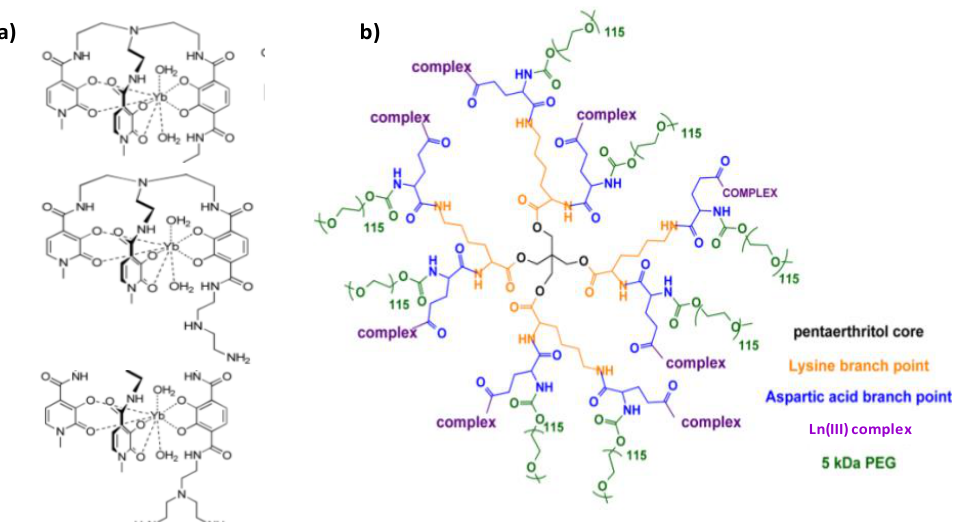
Figure 17. Structures of ( a ) Ln(III) complexes for MRI and NIR imaging agents and that of ( b ) the esteramide dendrimer scaffold. Reproduced from [213], with permission from ACS Publisher, 2012.